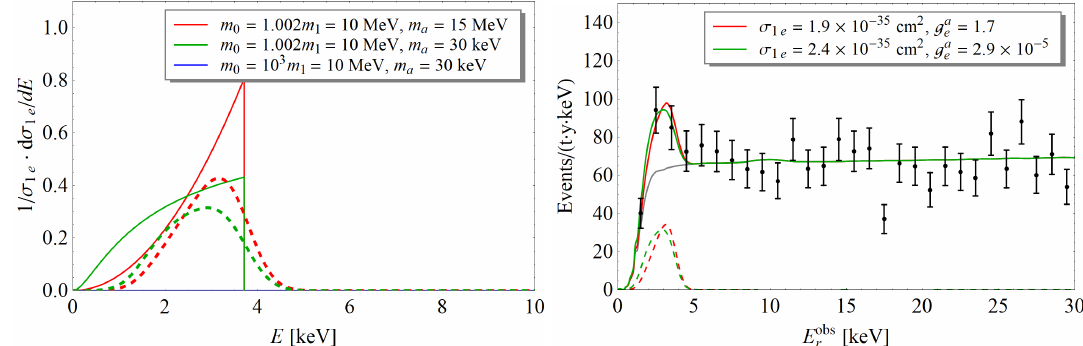
Figure 5 . [Left] The corresponding unit-normalized plots with the same benchmark mass spectra as in figure 2 but with the pseudo-scalar mediator and fermionic BDM (i.e., the PF case). The solid ( E ) and the dashed ( E obs ) lines are the spectra without and with detector effects, respectively. r r For the ( iii ) region, the spectrum is rising very slowly toward E max ≈ 9 . 75 MeV so that events with r keV-scale recoil energy are very unlikely to arise and the corresponding blue curve appears invisible. [Right] Sample energy spectra for the first two benchmark mass spectra. We assume g a = 1 and χ galactic BDM for which the flux is given by eq. (3.2). The values of σ and g a associated with 1 e e these fits are shown in the